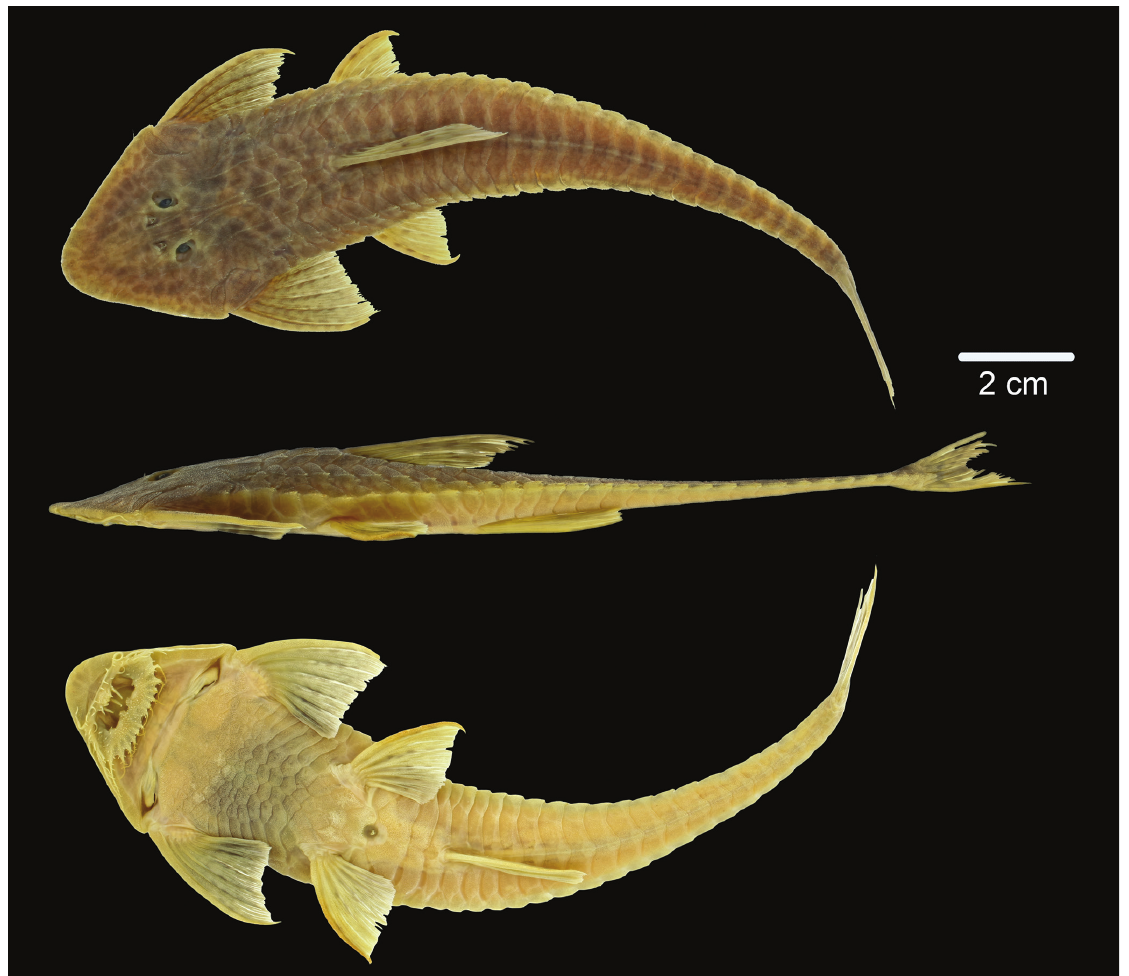
Fig. 1. Pseudohemiodon unillano, new species, holotype, IAvH-P 19034, 162.0 mm SL. Photograph by J.